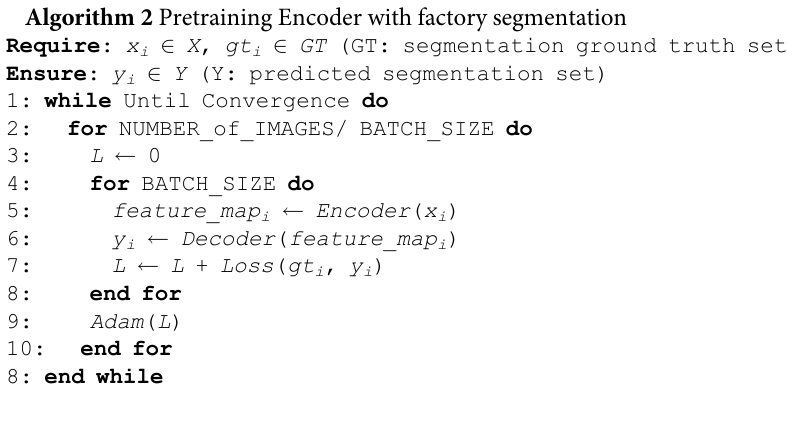
Algorithm 2 Pretraining Encoder with factory